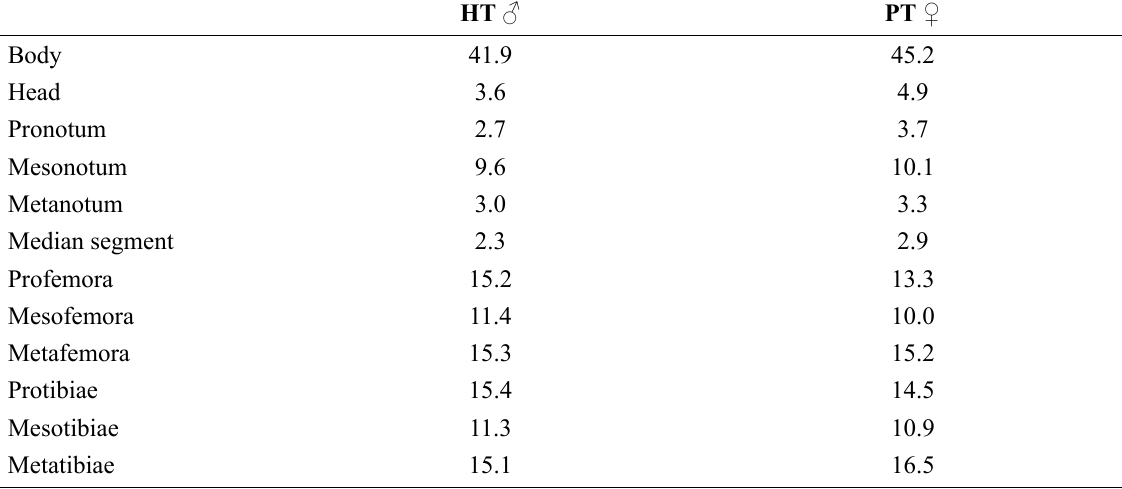
Table 2. Measurements (mm) of Otraleus bellemansae sp. nov. HT = holotype; PT =